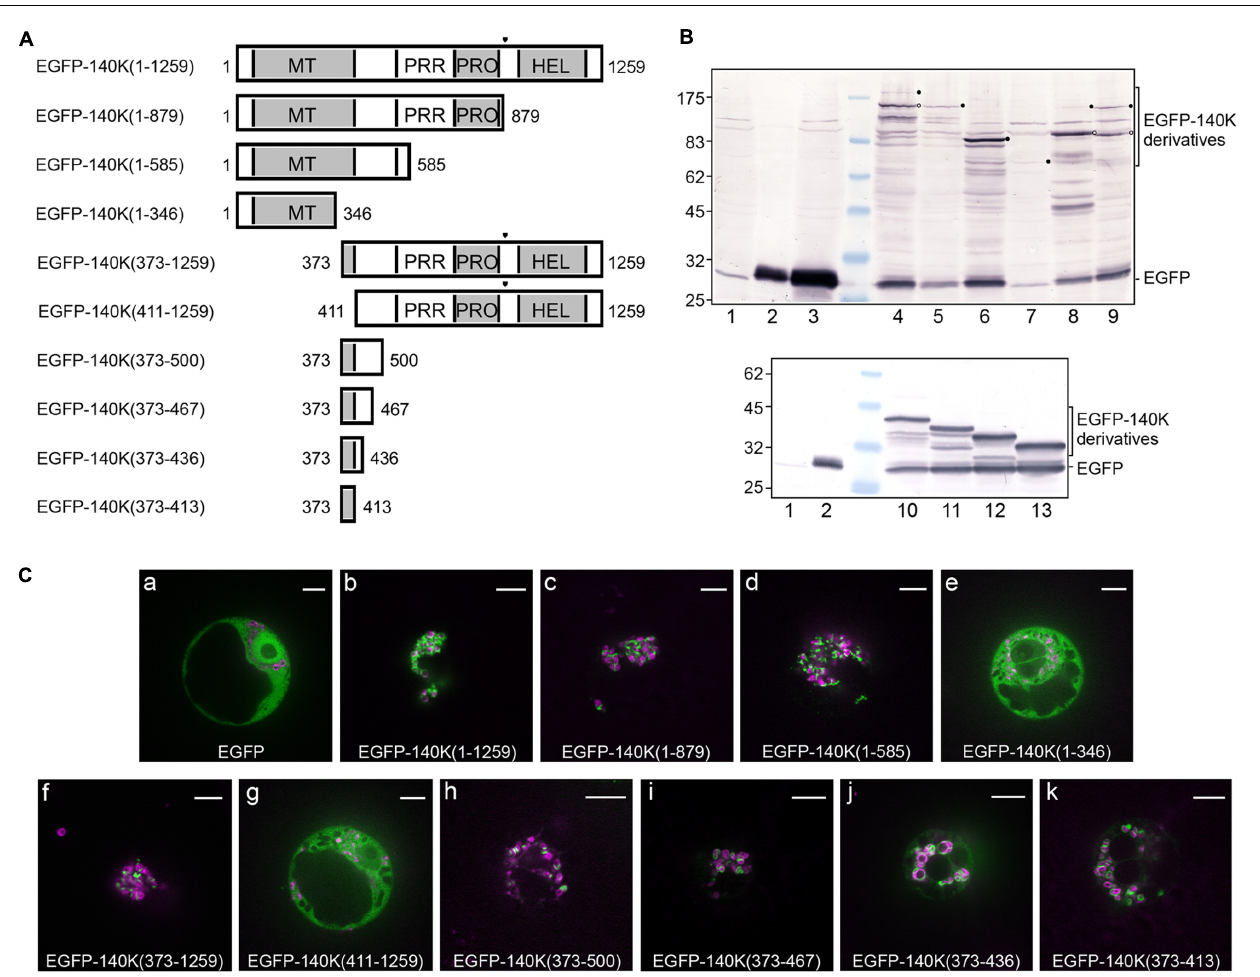
FIGURE 3 | Deletion mapping of the chloroplast targeting domain. (A) Schematic representation of the EGFP-140K derivatives. Protein domains are designated as in Figure 1 and the (PRO ↓ HEL) cleavage site is represented by a filled triangle. The EGFP moiety present at the N-terminus is not represented. (B) Arabidopsis protoplasts were transfected with water (lane 1) or the expression plasmids p (cid:127) -EGFP (lanes 2 and 3), p (cid:127) -EGFP-140K(1–1259) (lane 4), p (cid:127) -EGFP-140K(1–879) (lane 5), p (cid:127) -EGFP-140K(1–585) (lane 6), p (cid:127) -EGFP-140K(1–346) (lane 7), p (cid:127) -EGFP-140K(373–1259) (lane 8), p (cid:127) -EGFP-140K(411–1259) (lane 9), p (cid:127) -EGFP-140K(373–500) (lane 10), p (cid:127) -EGFP-140K(373–467) (lane 11), p (cid:127) -EGFP-140K(373–436) (lane 12) and p (cid:127) -EGFP-140K(373–413) (lane 13). The cells were harvested 48 h post-transfection (hpt) and equivalent amount of total proteins (except lane 2 which corresponds to 1/10th of the other samples) were subjected to 10% SDS-PAGE and immunoblot analysis with anti-GFP antibodies. Molecular mass markers (Biolabs) are indicated on the left, whereas positions of EGFP-140K derivatives and EGFP are indicated on the right. Filled dots indicate the position of full-length proteins, whereas open dots indicate the position of the mature product after processing at the (PRO ↓ HEL) cleavage site, when appropriate. (C) Arabidopsis protoplasts were transfected with the expression plasmids as indicated, together with p (cid:127) -RbCS-NiRFP. Single protoplasts were observed by spinning-disk confocal laser microscopy (SPCLM) 48 hpt and EGFP localization was observed (green). To visualize the localization of chloroplasts, NiRFP fluorescence and chlorophyll autofluorescence were acquired (magenta) and superimposed onto the EGFP fluorescence. Scale bars, 10 µ